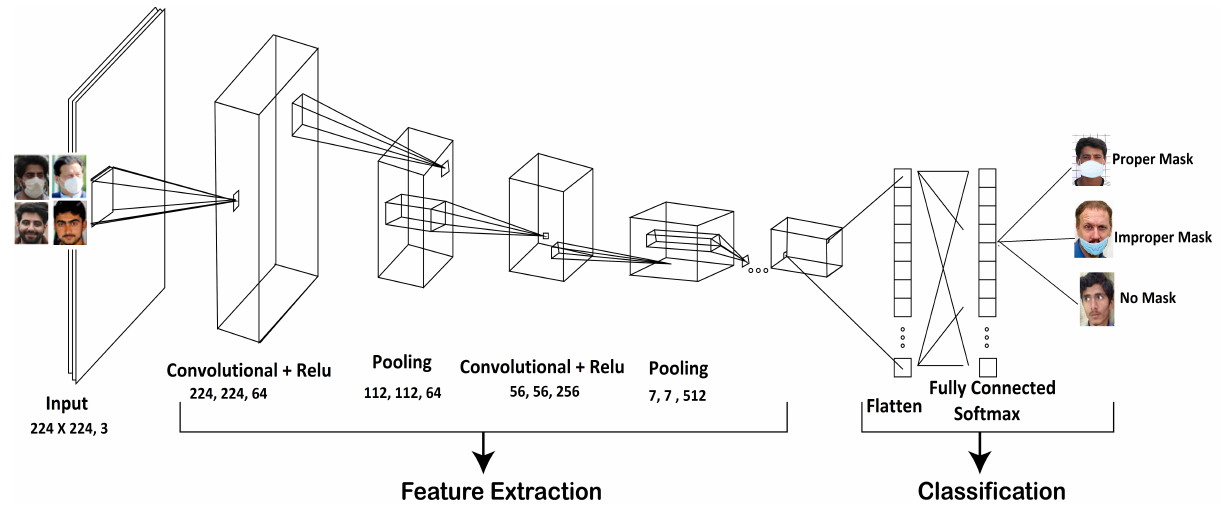
Figure 9. Architecture of Convolutional Neural Network (CNN)